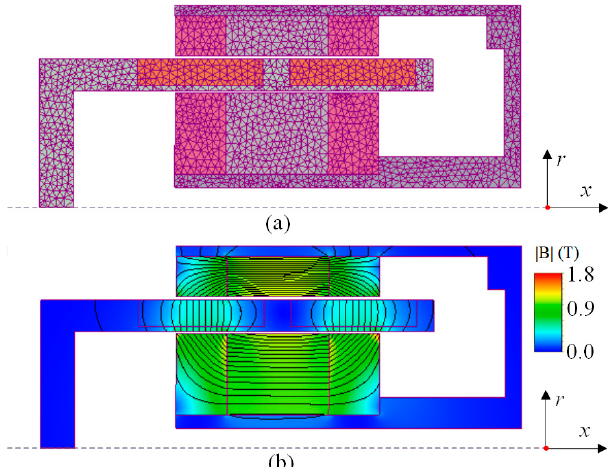
Figure 5. Finite element model of the linear motor, ( a ) mesh, ( b ) flux density.